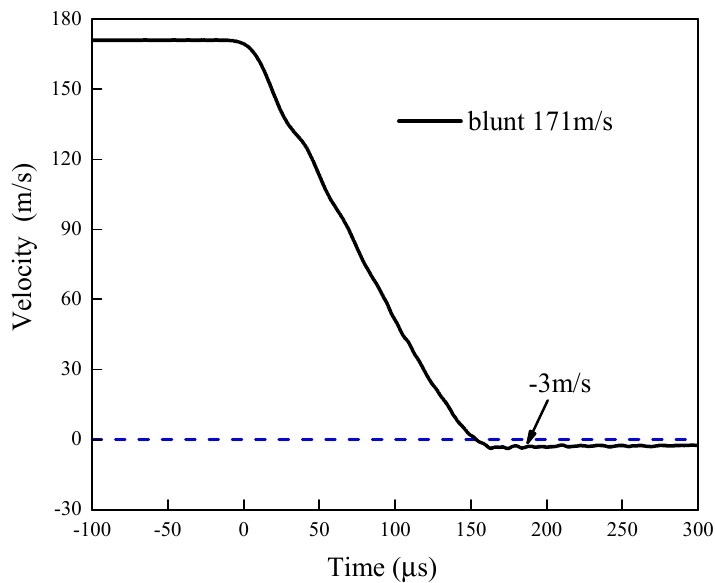
Figure 16. Velocity curve of the blunt projectile (171 m/s initial velocity) obtained by integrating the acceleration curve (Figure 15).